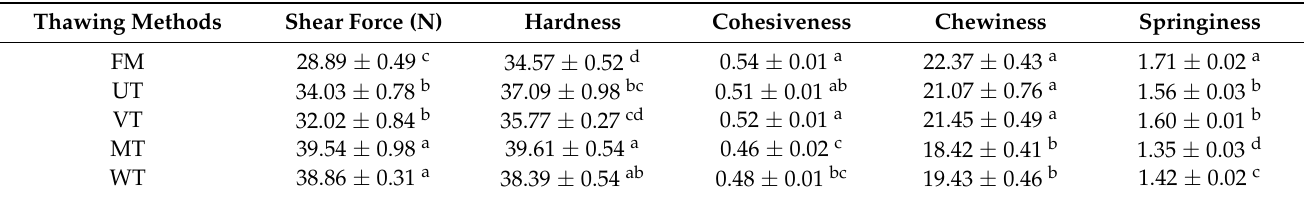
Table 3. Change in shear force and texture (hardness, cohesiveness, chewiness and springiness) of porcine longissimus dorsi induced by thawing